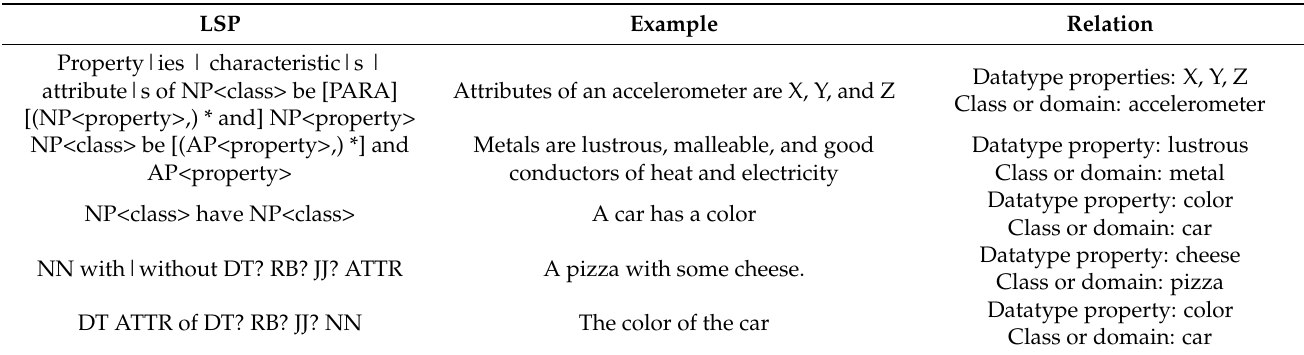
Table 4. LSPs for missing concept